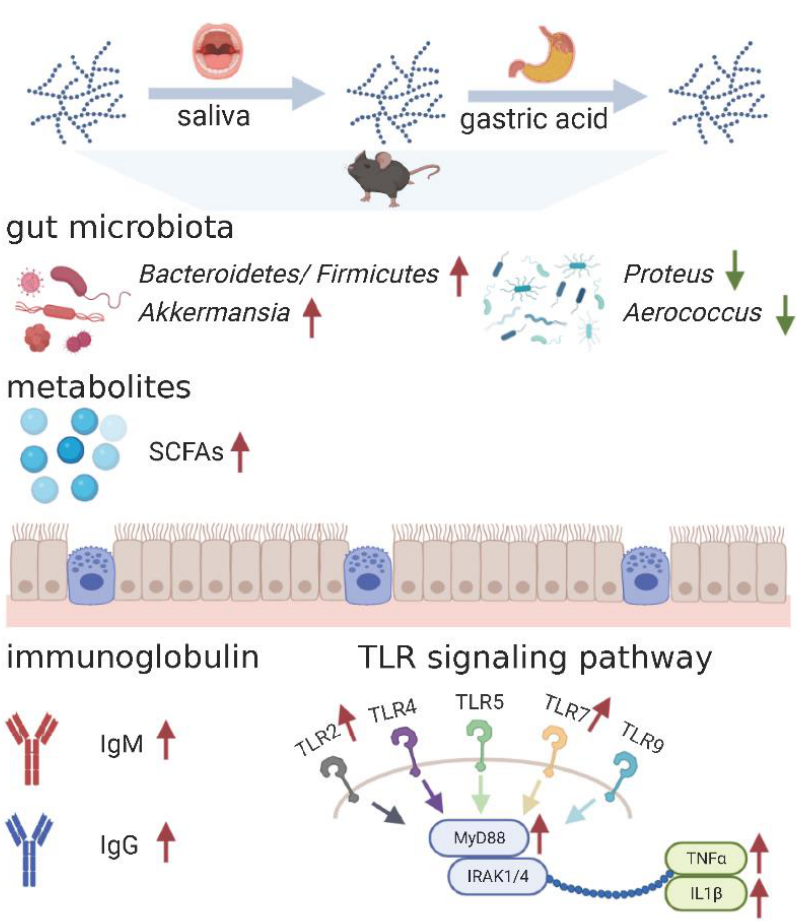
Figure 7. Potential mechanisms of the effects of PS on immune response. Red arrow represents up regulation; Green arrow represents down regulation; SCFAs: short-chain fatty acid. This figure was created with icons provided by bio render (https://biorender.com (assessed on 10 October, 2021)). Supplementary Materials: The following are available online at www.mdpi.com/xxx/s1, Table S1: Chemical characterization of PS.